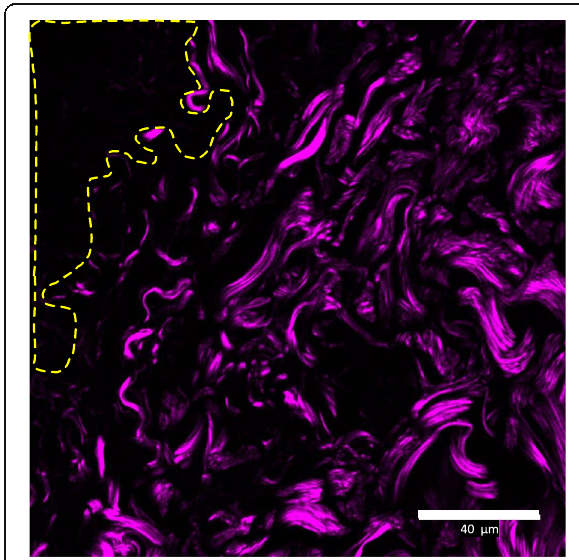
Fig. 5 Melanoma specimen. Yellow dashed line represents cluster of neoplastic cells. Transition with neoplastic cell aggregates shows reduced amount of collagen. Stroma more distant to tumor presents increasing amounts of